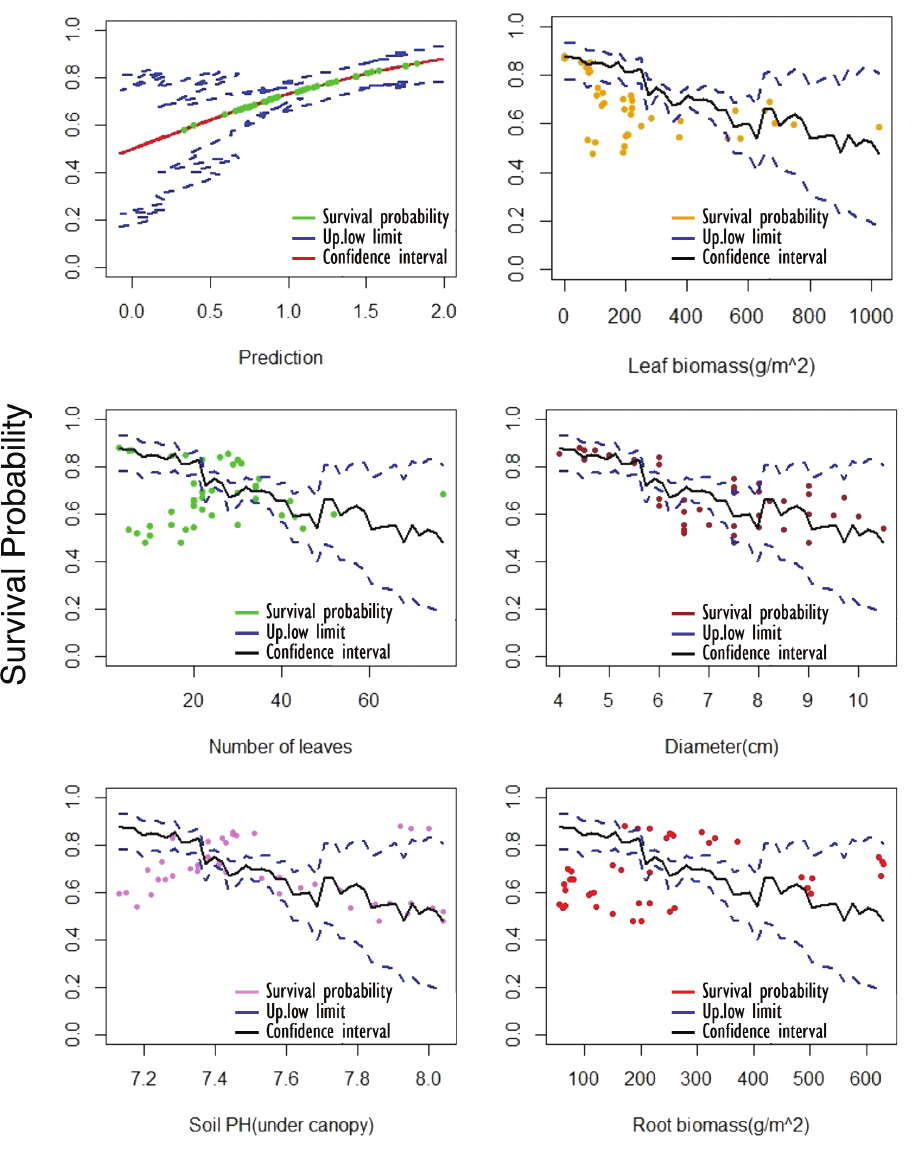
Figure 3. The relationship between survival probability and predictors from the top model for wasteland